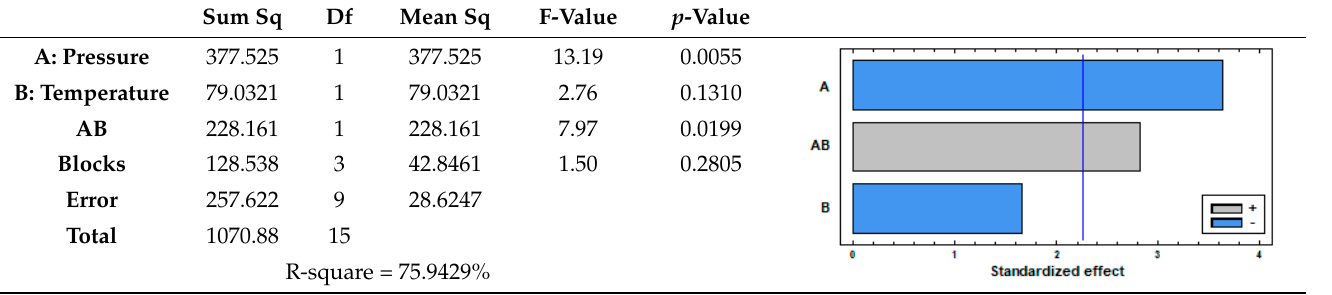
Table 5. ANOVA table and Pareto chart for quadratic model of antioxidant activity of impregnated TPU.